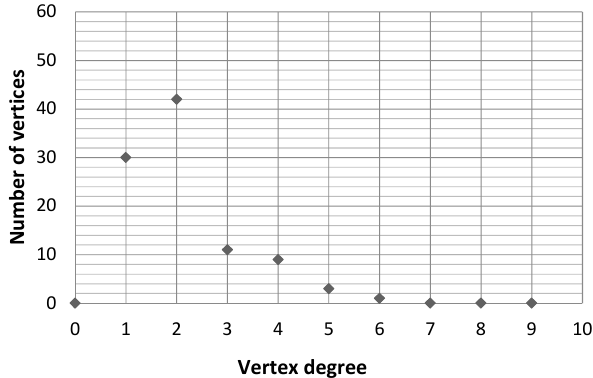
Figure 7. The vertex degree distribution after the STW has been removed.